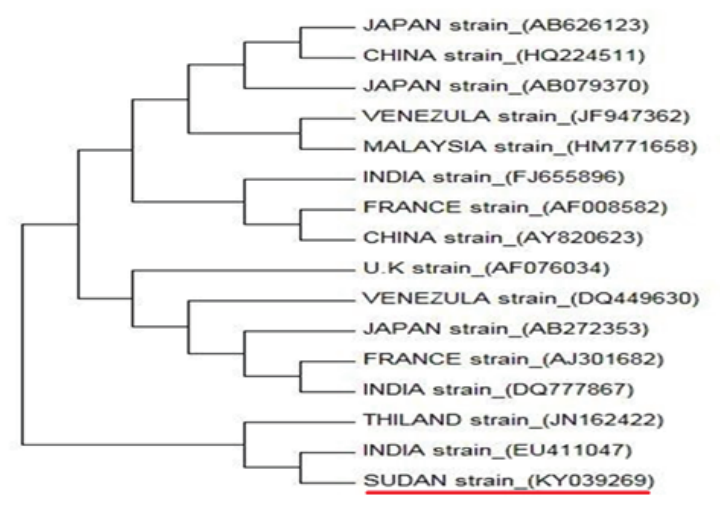
Figure 3: Phylogenetic tree of 16S rRNA gene of P. mirabilis isolate from Sudanese notes (KY